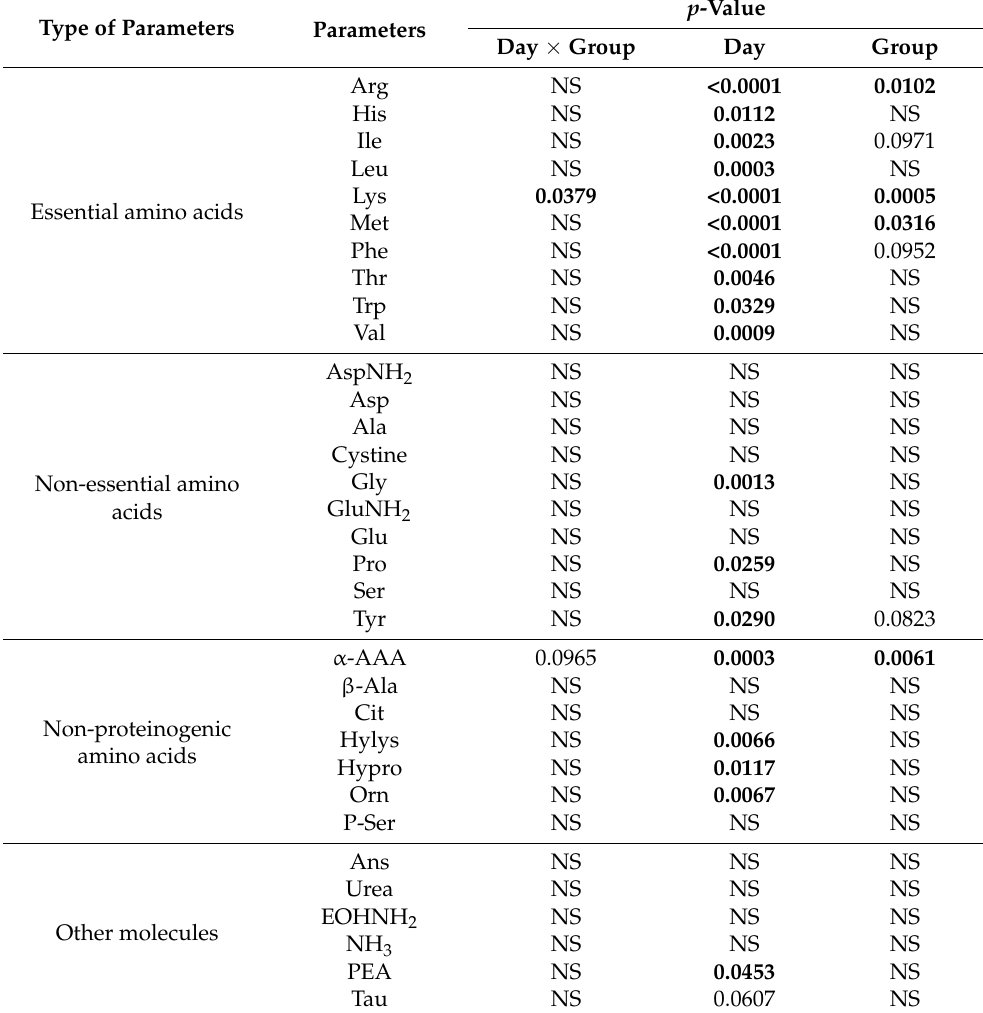
Table 1. p -values associated with the groups (low activation vs. high activation) and culture periods (day 2 vs. day 4 vs. day 6) in cortical strip culture of bovine ovaries on amino acid metabolism.